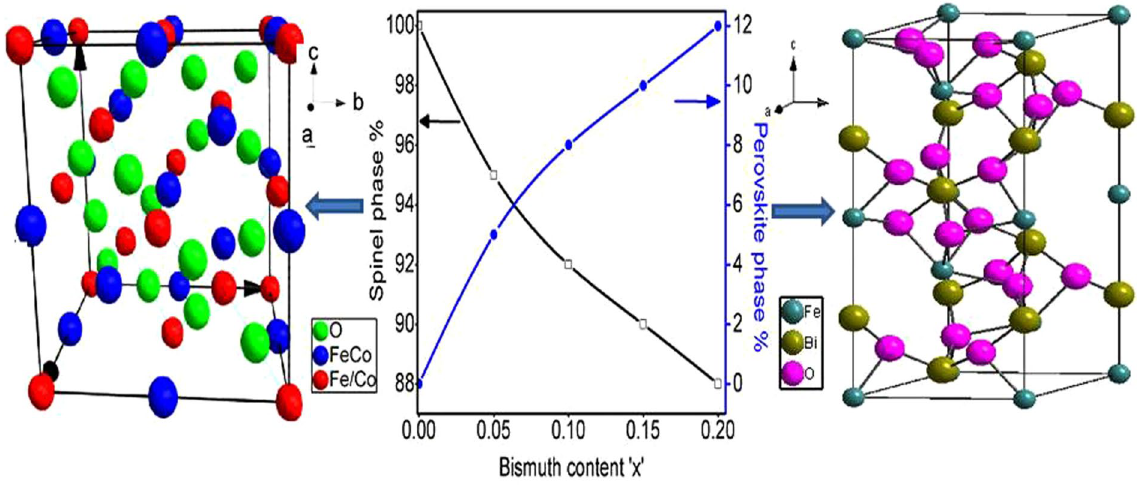
Figure 3. Influence of Bi 3 + -doping on spinel (left) and perovskite (right) phases of